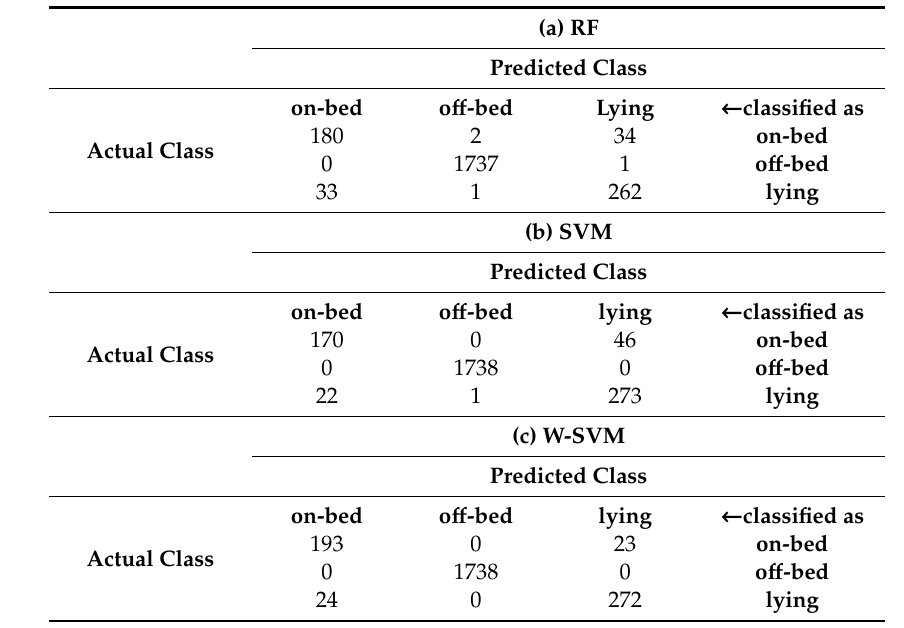
Table 4. Smartphone results using di ff erent classification algorithms ( a ) Random Forest, ( b ) SVM, ( c )